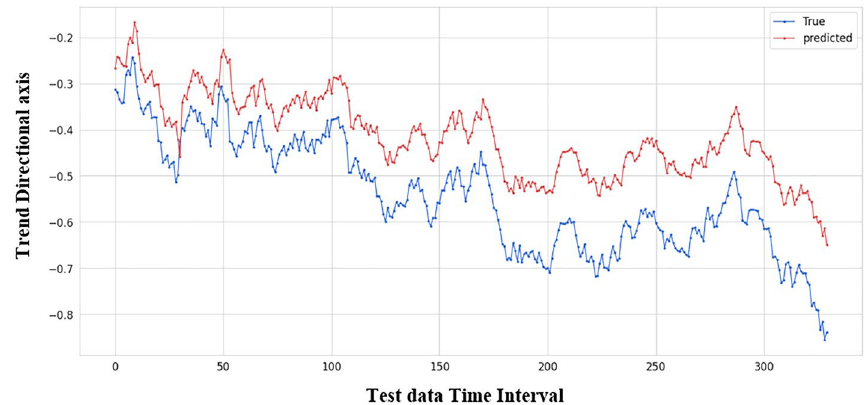
Fig. 7 AUDUSD—graph of true vs. predicted trends